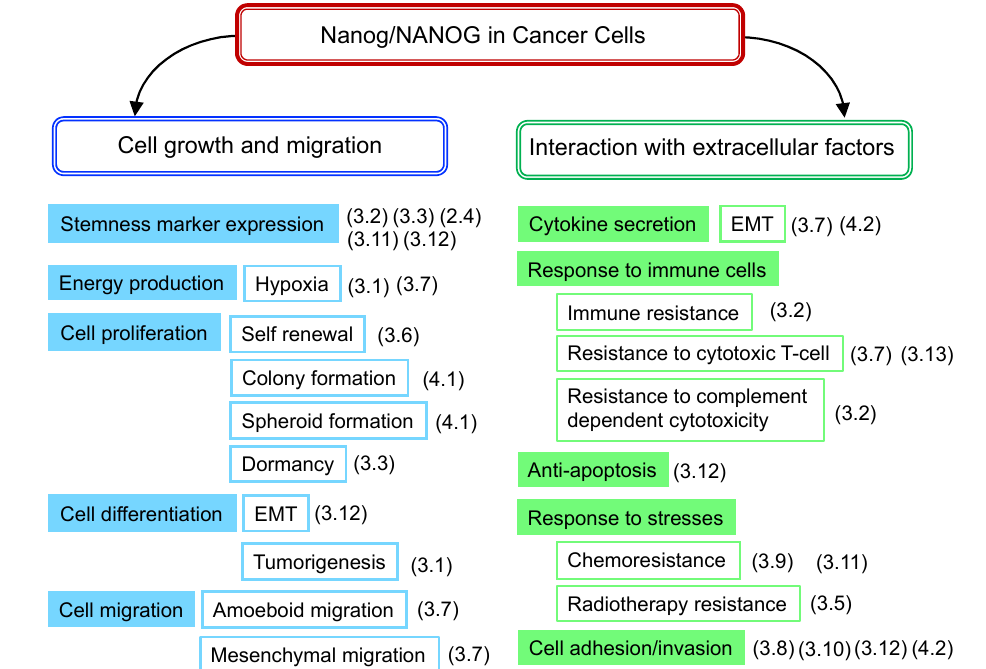
Figure 3. Results of transcriptome analysis. ( A ) Differential expression of Nanog -dependent genes between Nanog + BL6 and B16-BL6 cell lines. Assumed-role diagrams of up-regulated top-7 genes